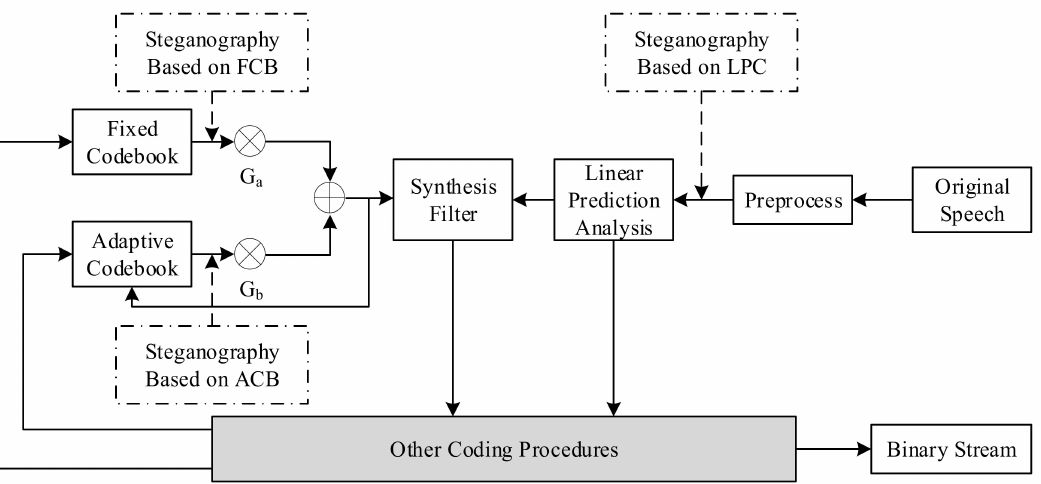
Figure 4. VoIP steganography distribution map based on voice